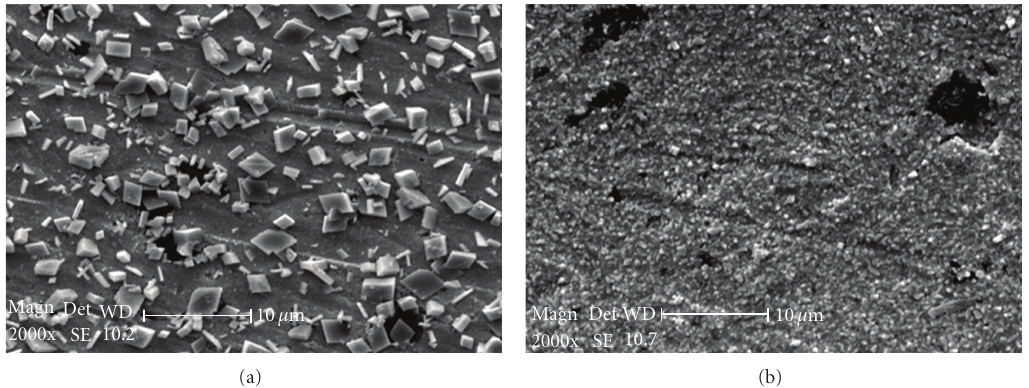
Figure 9: The scanning electron micrographs (SEM) of Pb-1.66% Sb-Sn alloy after one cycle of charge and discharge in H 2 SO 4 without additive (a) and in the presence of 15.0 µ g · L − 1 of THAHS (b).